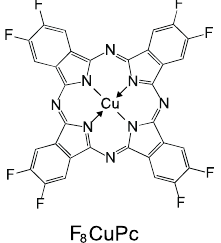
Figure 1. Structural formula of F 8 CuPc.